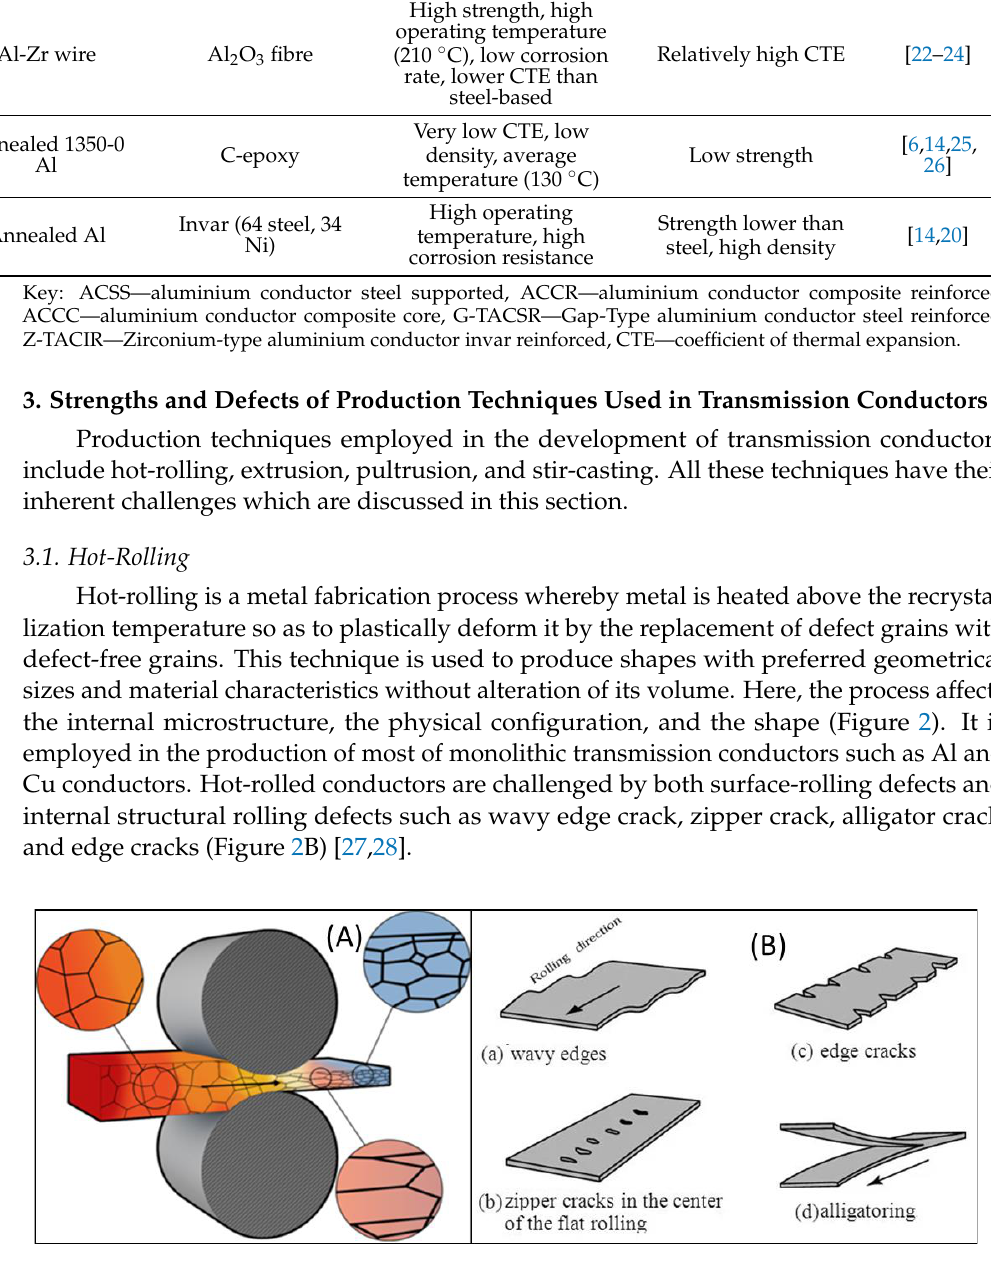
Figure 2. Image of Hot-Rolled Composite Sample Showing Alteration in Microstructure and the Phys- ical Geometry [29]. ( A ) Alteration in Microstructure and Physical Structure, ( B ) Defects Associated with Hot Rolling